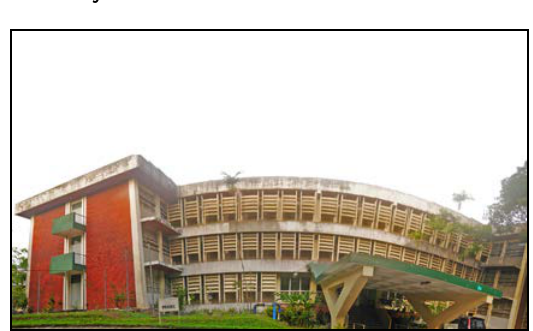
Figure 1. Panoramic view of Kalayaan Residence